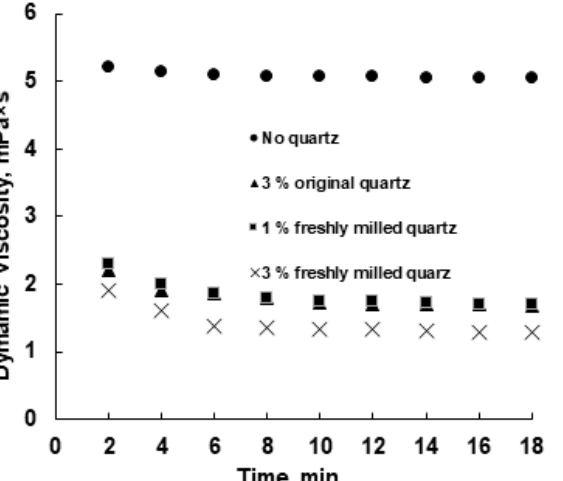
Figure 10. Influence of the original and freshly milled quartz particles on the w/o emulsion viscosity.